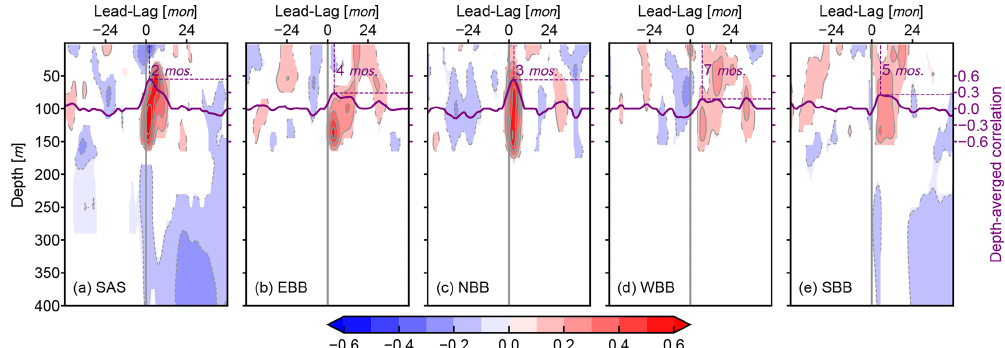
Figure 12. Lead–lag Pearson correlation coefficient between the DMI and the salinity anomaly of subareas SAS (a) , EBB (b) , NBB (c) , WBB (d) , and SBB (e) at different depths from HAMSOM. The contour intervals are 0.1. The analysis period is from 1960 to 2005. Only significant correlation coefficients with p value < 0 . 05 are shaded. Solid purple lines indicate the depth-averaged correlation over 50–150m. Dashed purple lines indicate the highest correlation and the corresponding lag.